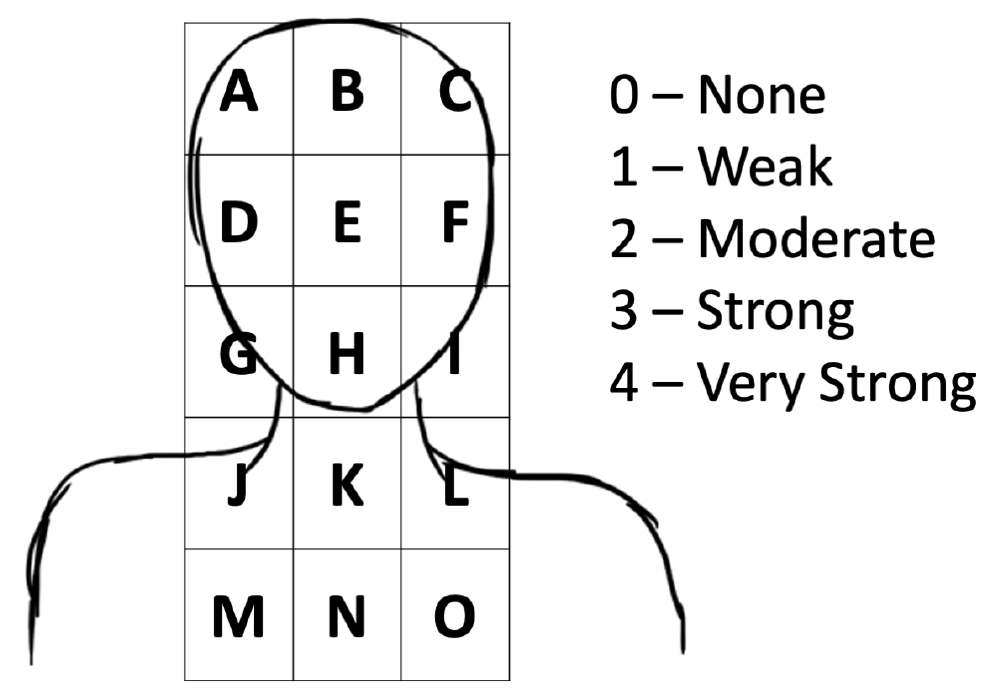
Figure 2. Novel oral cooling scale. Used to rate the location and intensity of (oral) cooling across regions that are likely to regions that are likely to be menthol be menthol sensitive.